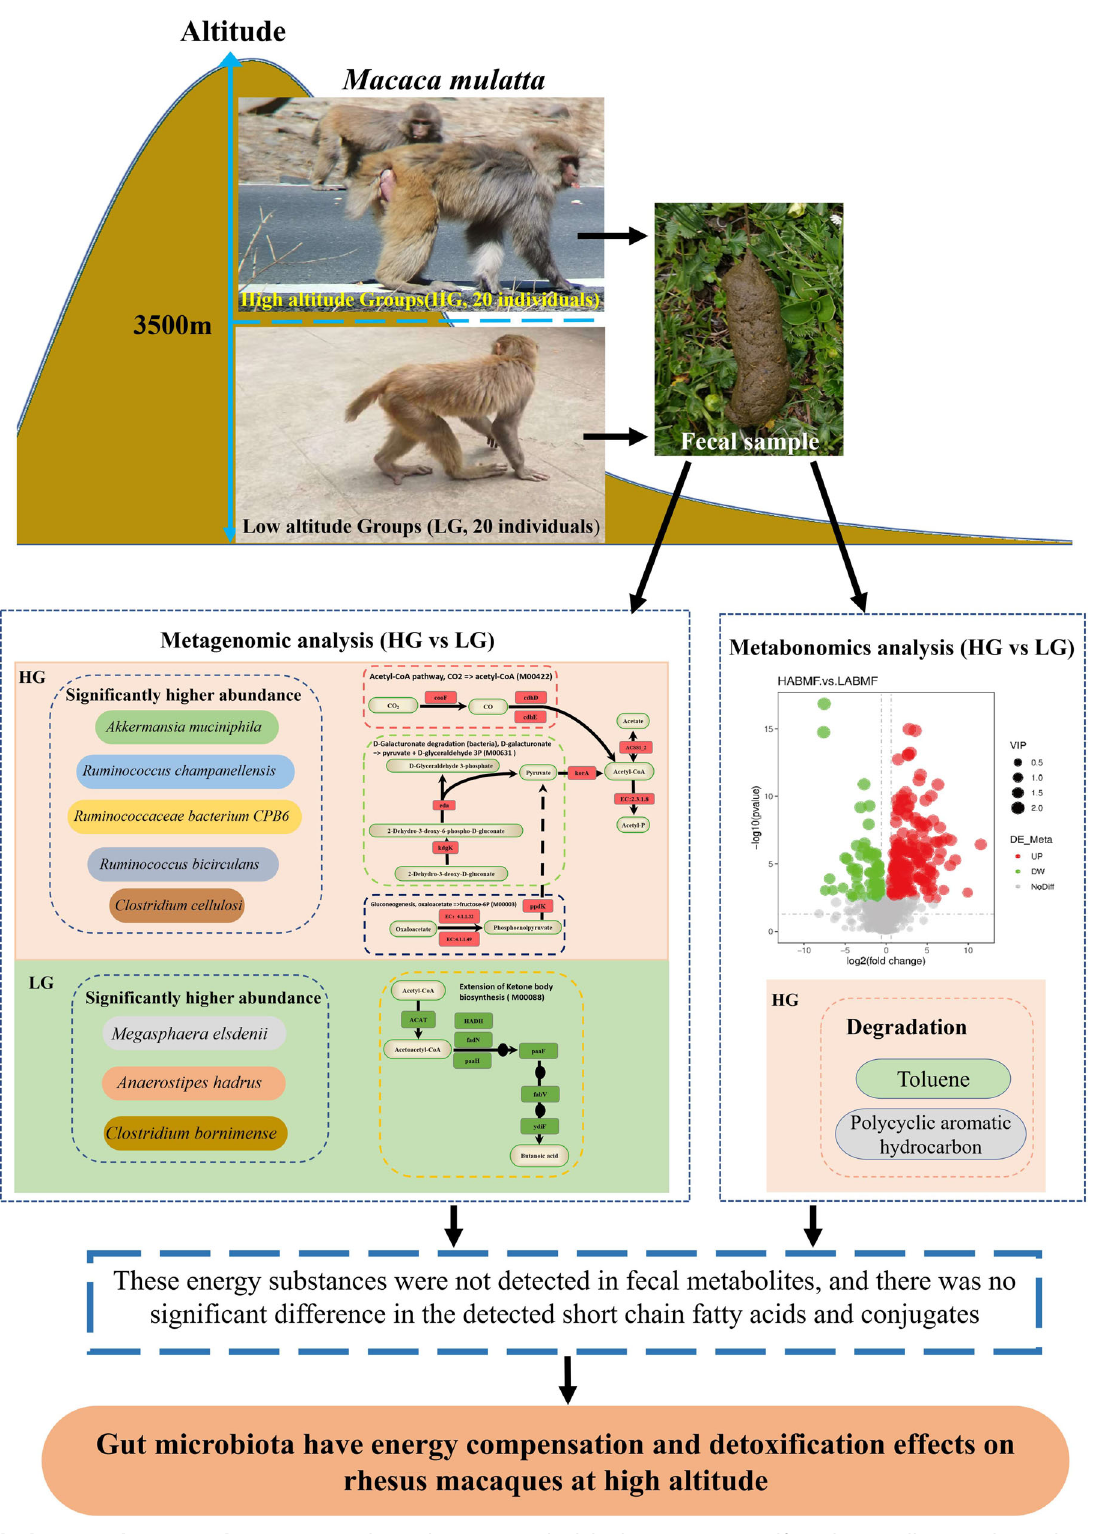
Fig. 7 Study design and main results. cooF anaerobic carbon-monoxide dehydrogenase iron sulfur subunit, cdhD acetyl-CoA decarbonylase/ synthase, CODH/ACS complex subunit delta, cdhE acetyl-CoA decarbonylase/synthase, eda 2-dehydro-3-deoxyphosphogluconate aldolase, kdgK 2-dehydro-3-deoxygluconokinase, E4.1.1.32 phosphoenolpyruvate carboxykinase, E4.1.1.49 phosphoenolpyruvate carboxykinase, ppdK pyruvate, orthophosphate dikinase, korA 2-oxoglutarate/2-oxoacid ferredoxin oxidoreductase subunit alpha, ACSS1_2 acetyl-CoA synthetase, EC:2.3.1.8 putative phosphotransacetylase. Red indicates that relative abundance was signi fi cantly higher in high-altitude populations. Green indicates that abundance was signi fi cantly higher in low-altitude populations. These macaque photos were taken by ourselves. These images and every element of these images were created by